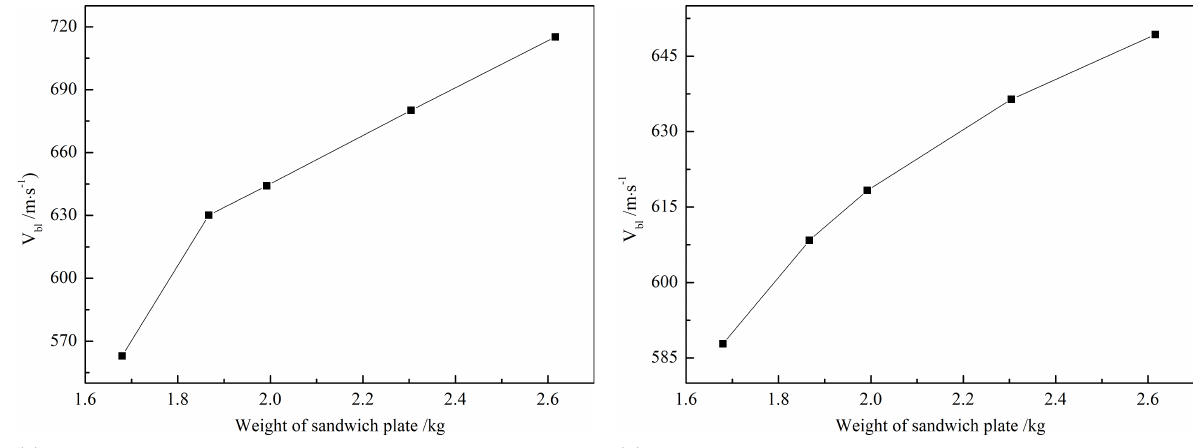
Figure 12: Weight of steel/nylon sandwich plates versus ballistic